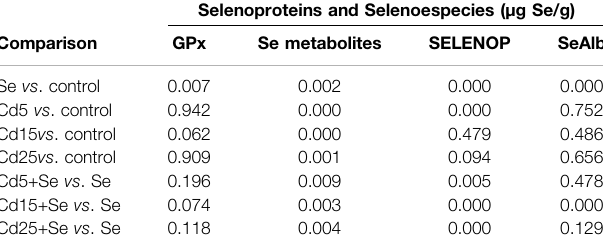
TABLE 3 | p -values obtained for each comparison. Signi fi cance level p < 0.05. Selenoproteins and Selenoespecies (µg